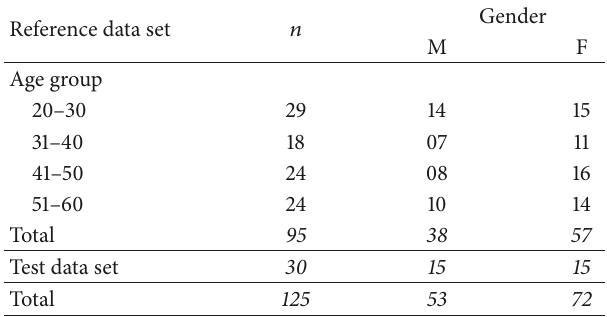
Table 1: Sample distribution across gender and different age group in the reference group.